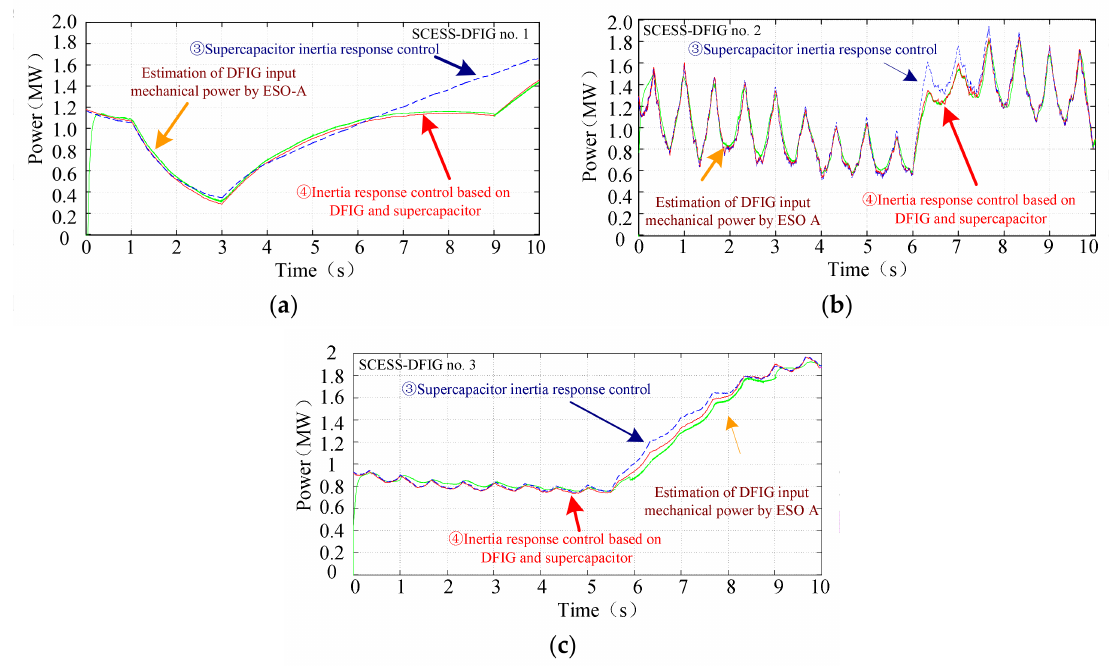
Figure 23. The input mechanical power comparison of SCESS-DFIG under different control strategies and the input mechanical power estimation of ESO-A: ( a ) The input mechanical power comparison of no. 1 SCESS-DFIG under different control strategies and the input mechanical power estimation of ESO-A; ( b ) The input mechanical power comparison of no. 2 SCESS-DFIG under different control strategies and the input mechanical power estimation of ESO-A; ( c ) The input mechanical power comparison of no. 3 SCESS-DFIG under different control strategies and the input mechanical power estimation of